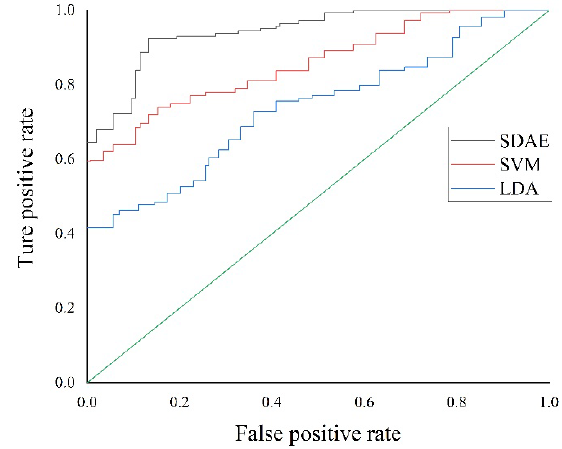
Figure 17. ROC curves of three models.